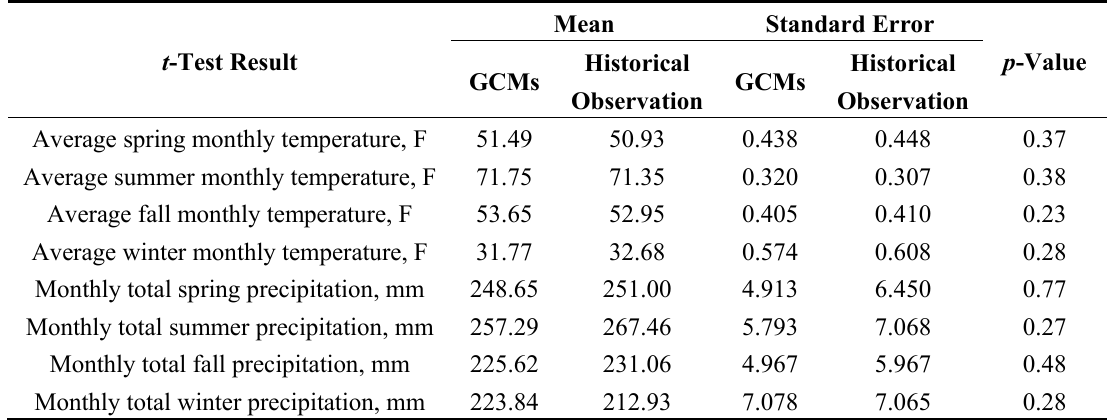
Table 1. Comparisons between observed and Global Climate Models (GCM) projected temperatures and precipitations via t -test.